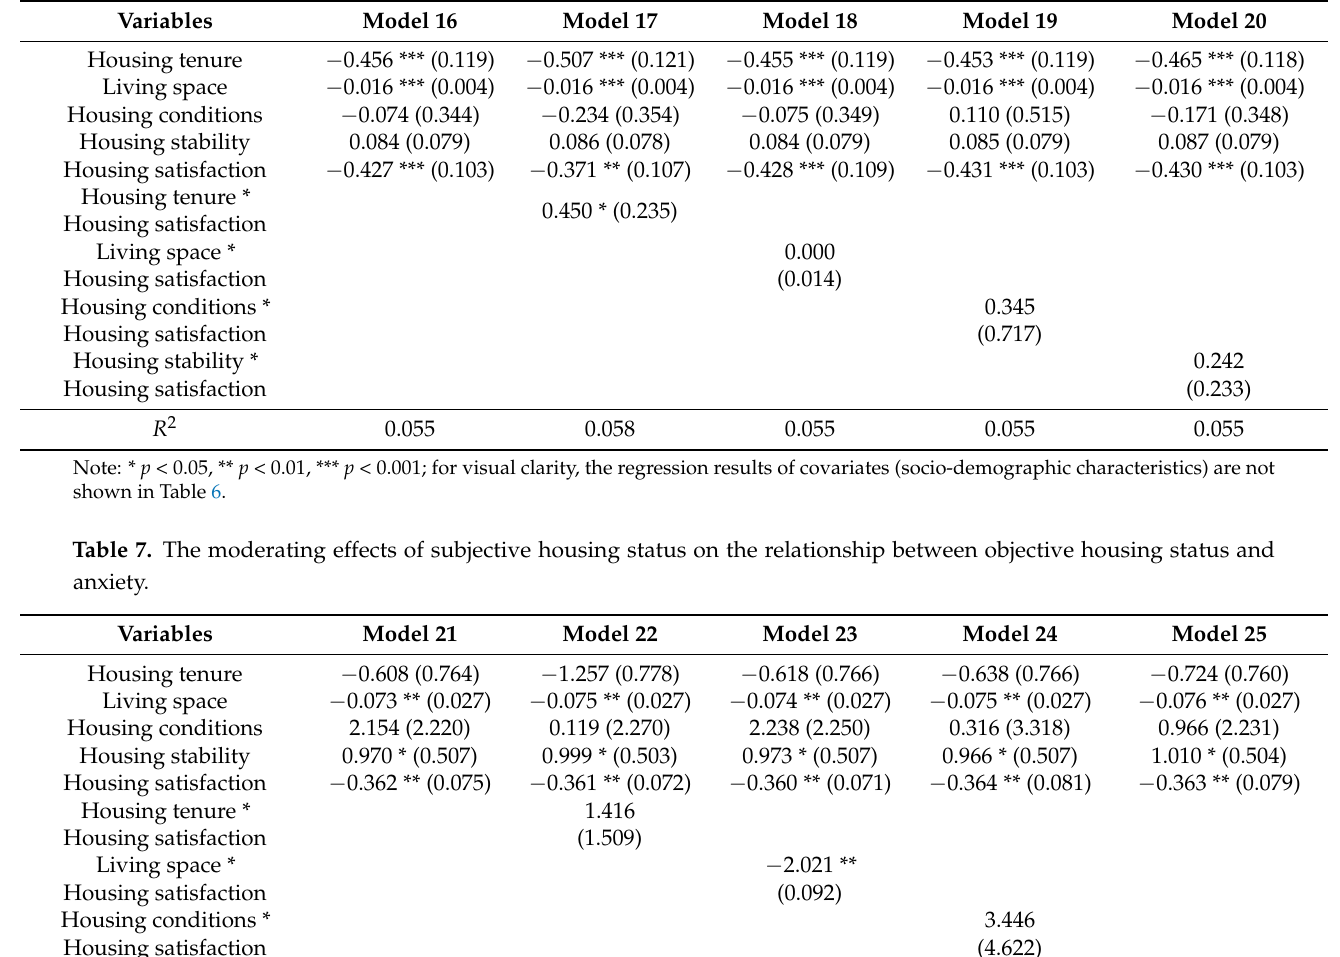
Table 6. The moderating effects of subjective housing status on the relationship between objective housing status and stress.